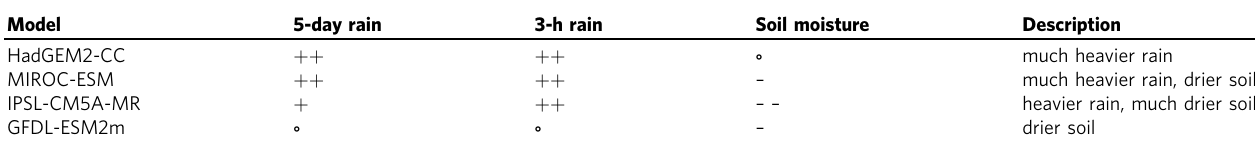
Table 1 Hydrometeorological storylines. Soil moisture values refer to the day prior to the 5-day aggregation period.